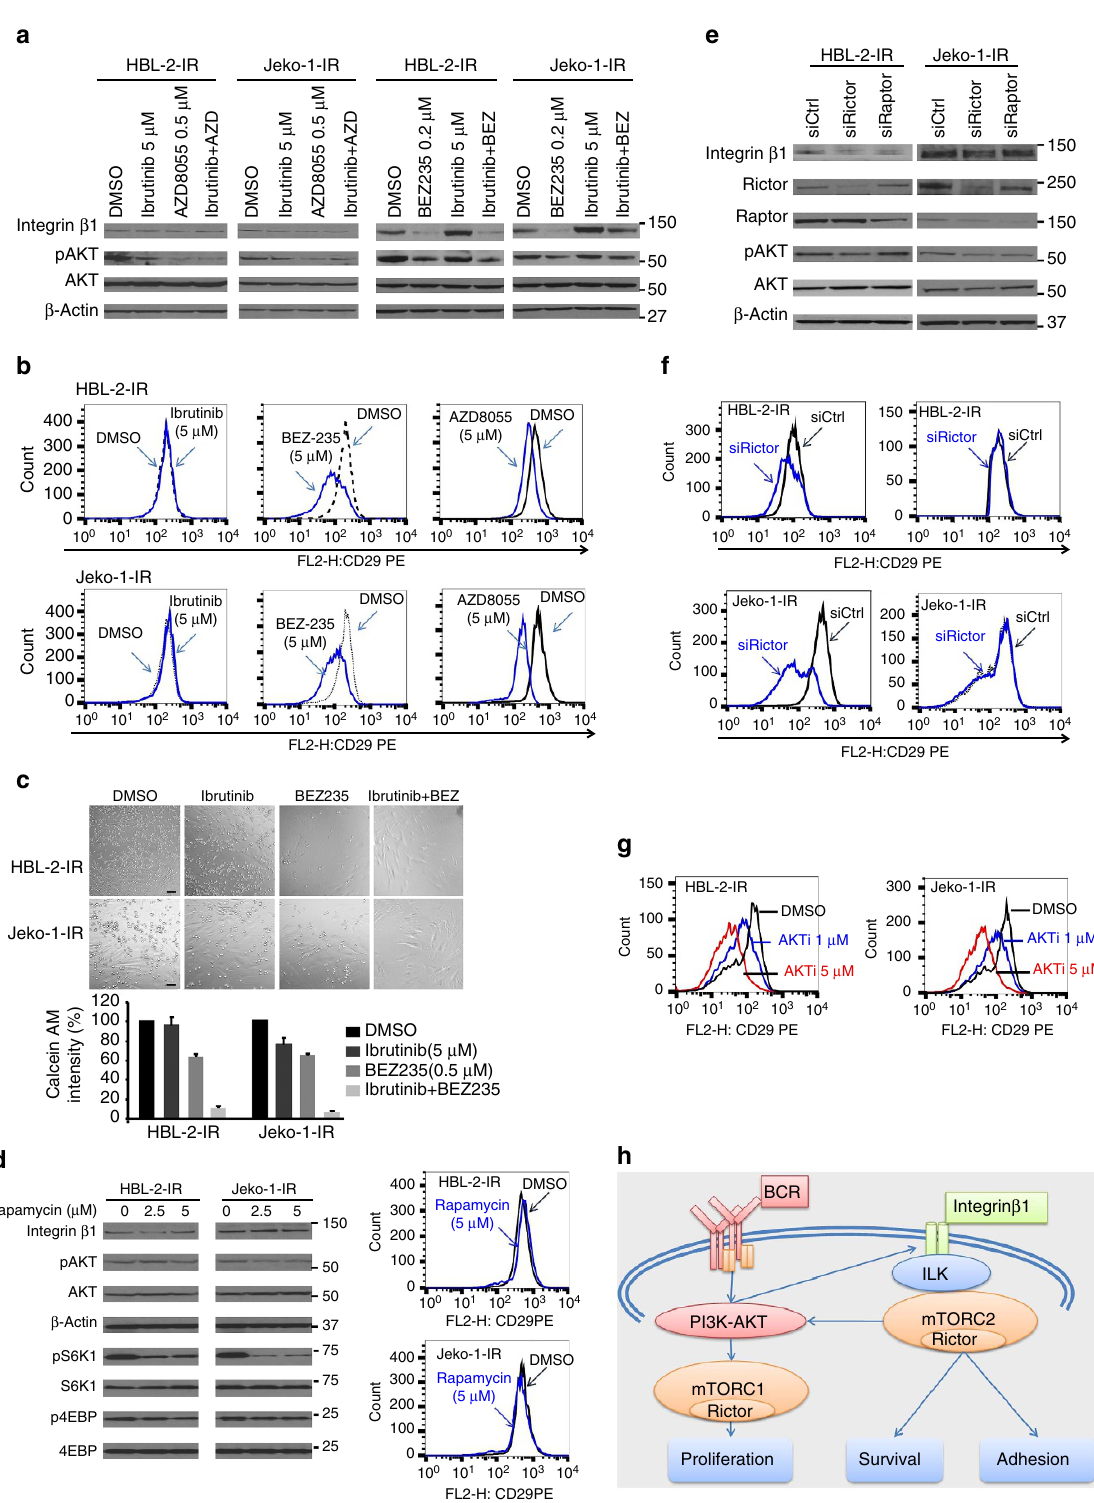
Figure 4 | Functional dissection of mTORC1 and mTORC2 in cell growth and stroma/MCL interaction in acquired IR MCL cells. ( a – c ) Treatment with the PI3K/mTOR inhibitors BEZ235 and AZD8055, but not ibrutinib, significantly decreased AKT phosphorylation, b 1 expression ( a , b ), and adhesion to HK stromal cells ( c ) in IR MCL cells. ( d ) Rapamycin inhibited mTORC1 activation, but had no effect on AKTactivation and b 1 expression in IR MCL cells. ( e , f ) Inhibition of mTORC2 by rictor knockdown using a pool of siRNAs decreased AKT activation, b 1 expression and cell adhesion. In contrast, blocking mTOR1 by raptor knockdown with siRNA showed no changes in AKT activation and b 1 expression in IR MCL cells. ( g ) Treatment with AKT inhibitor (AKTi, A674563, for 12h) significantly attenuated b 1 (CD29) expression in IR MCL cells. ( h ) Diagram of functional regulation of mTORC1 and mTORC2 in proliferation, AKT activation, b 1 expression and cell adhesion in IR cells. Results in a – g are representative of at least three independent experiments or means ± s.d. from at least three biological replicates. See also Supplementary Figs 4, 8 for full gel scan of the